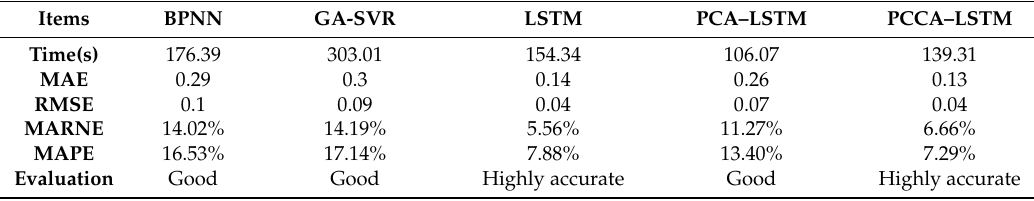
Table 4. The forecasting results in Athens case.